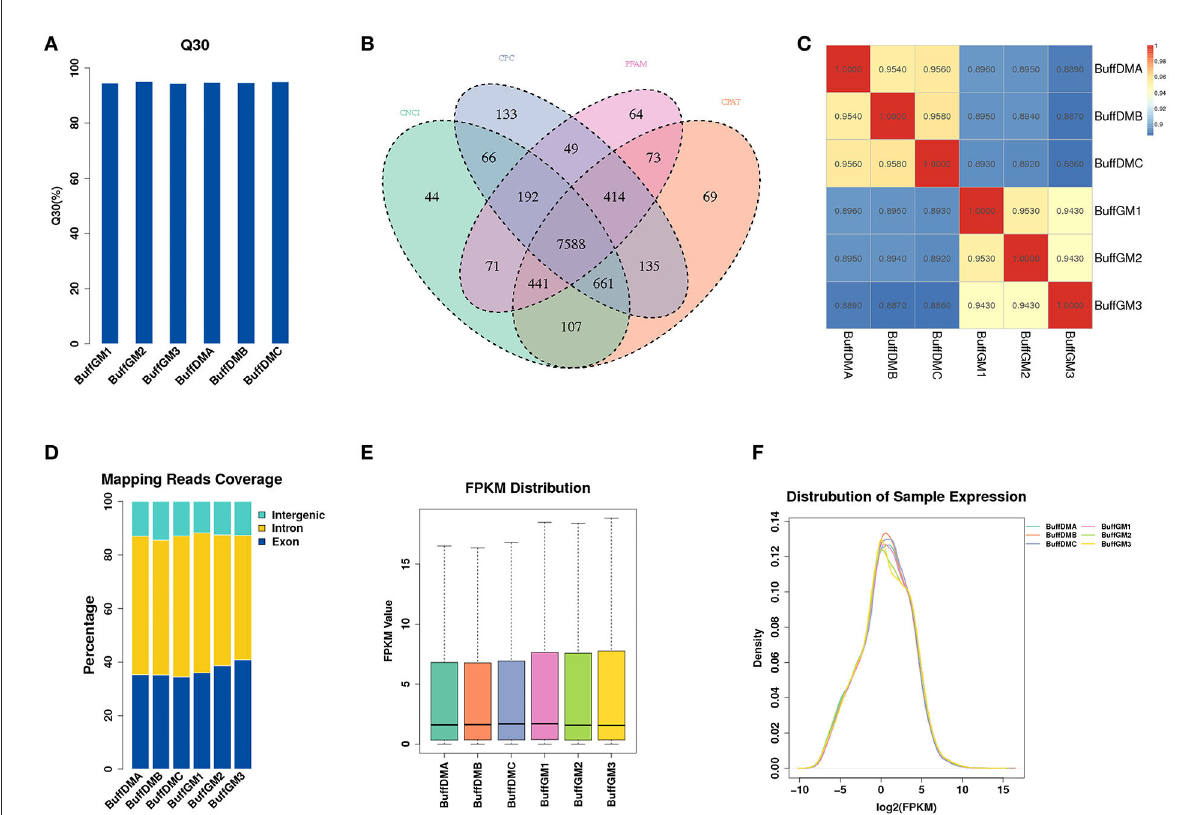
FIGURE1 Identification of lncRNAs in proliferating and differentiating buffalo myoblasts. (A) The clean Q30 base rate (%). (B) A Venn diagram depicting the overlap of lncRNAs found in the six samples. (C) The performance of Ribo-Zero RNA-seq was evaluated by determining the correlation of lncRNA expression. (D) The classification of lncRNAs, as defined by their genomic localization. (E,F) The expression of lncRNAs in the six samples. BuffGM represents buffalo muscle cells at the proliferative phase and BuffDM represents buffalo muscle cells at the differentiation phase.